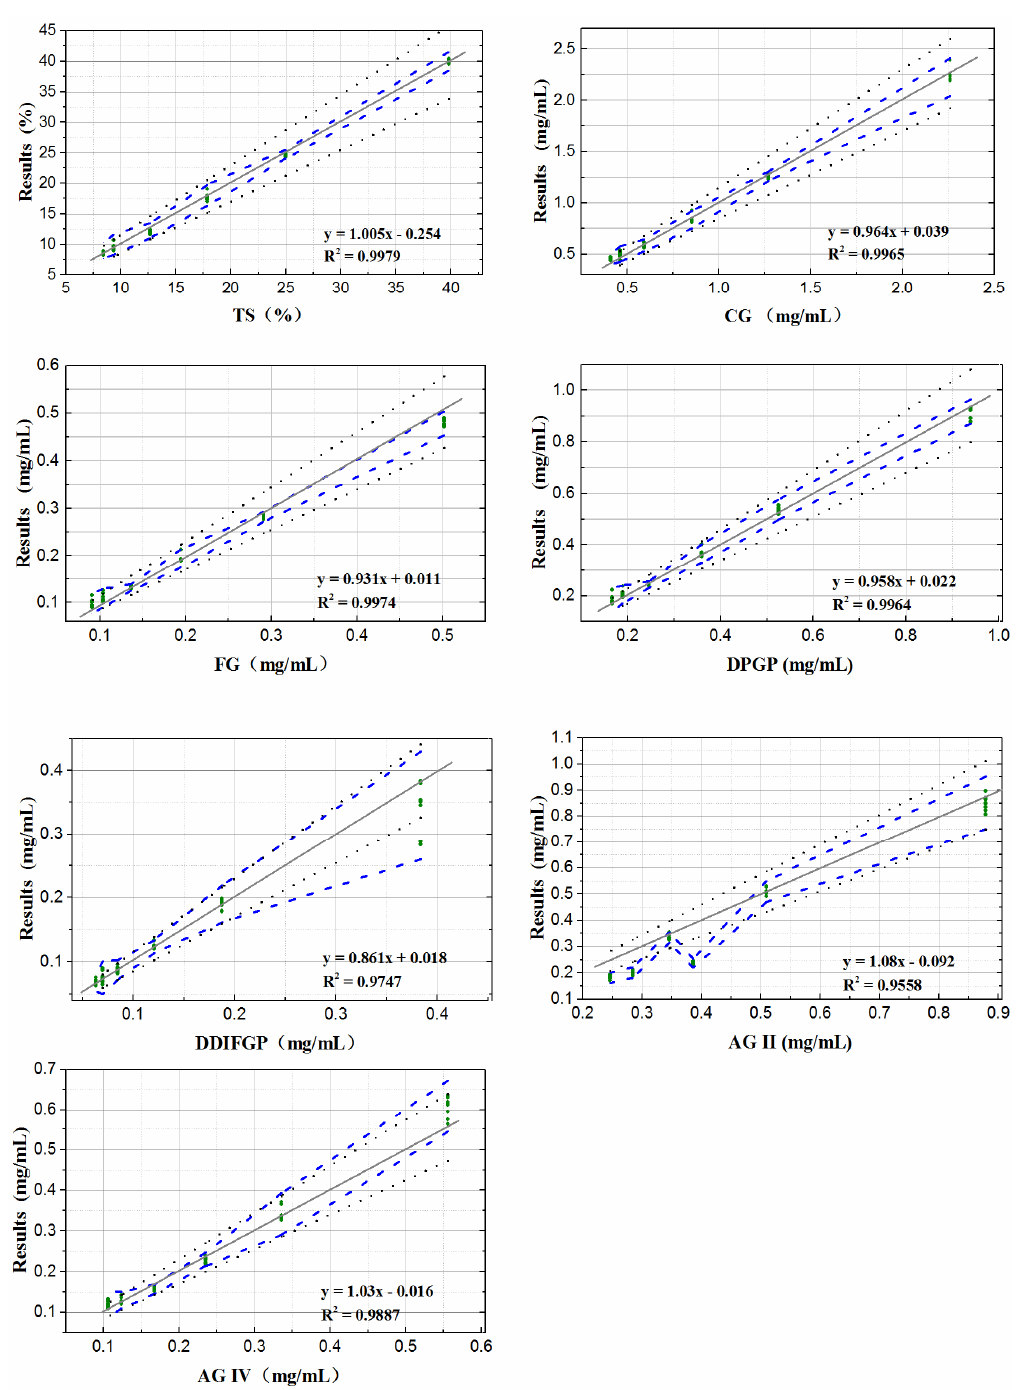
Figure 7. Linear profiles for the 7 PLSR models. (The dashed blue lines on this graph correspond to the accuracy profiles, i.e., the β -expectations tolerance limits expressed in absolute values. The dotted black lines represent the acceptance limits at ±15% expressed in concentration units. The solid line is the identity line for y = x).